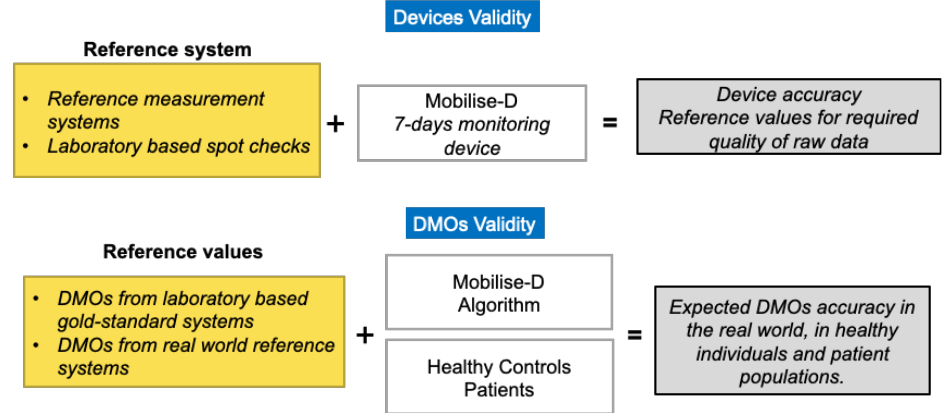
Figure 2. Mobilise-D Approach to test devices and DMOs validity.